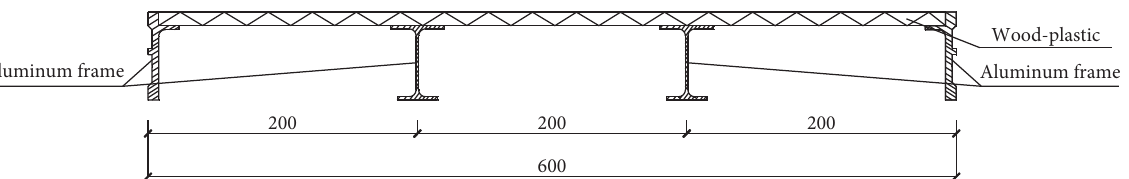
Figure 30: Actual cross section of the formwork.